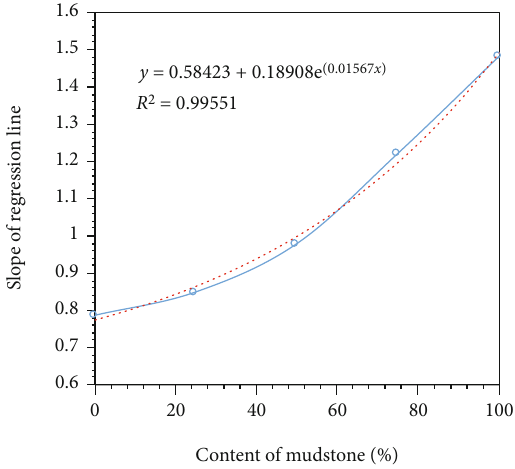
Figure 12: The relationship between the slope of fi tting line and content of